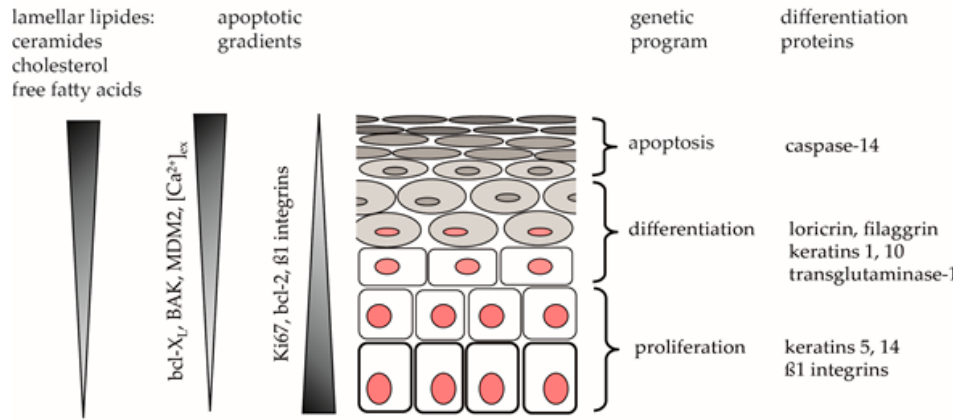
Figure 1. Illustration of the differentiation process in keratinocytes. The triangles indicate increasing or decreasing concentrations of the respective molecules within the epidermis. Bcl-2—B-cell lymphoma 2; BAK—Bcl-2 antagonist/killer1; MDM2—mouse double minute 2 homolog; Ca 2+ —calcium. The graphic was adapted from